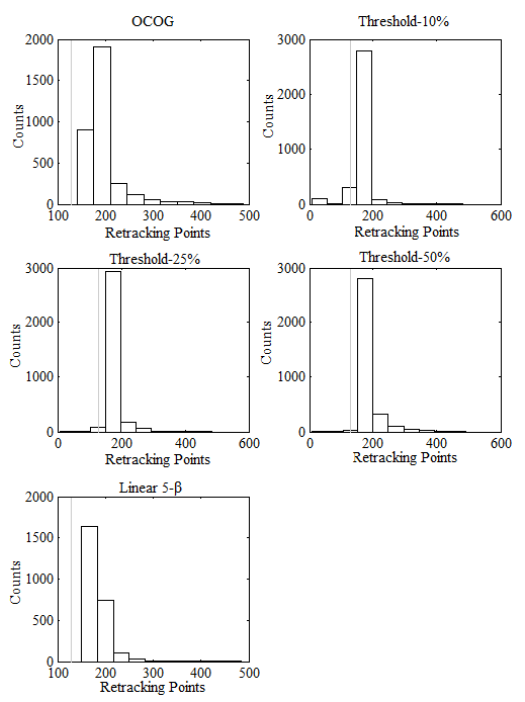
Figure 5. Histograms of retracking results for SARIn waveforms, the gray line indicates the pregiven